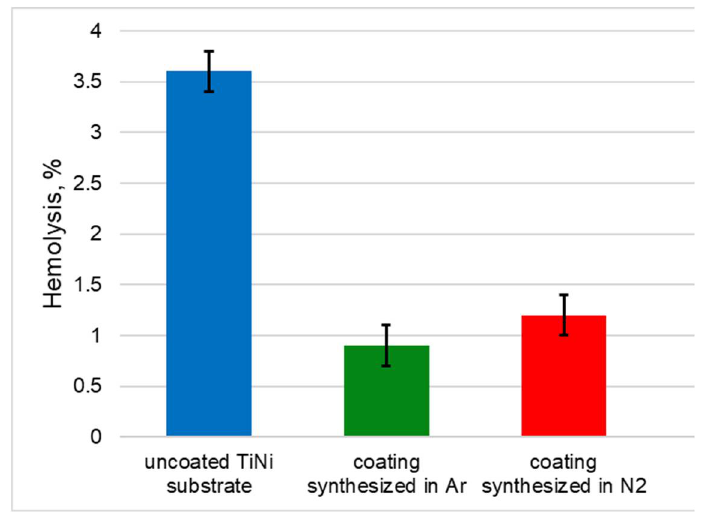
Figure 2. Percentages of erythrocyte hemolysis.